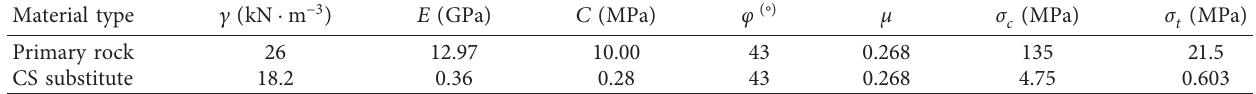
Table 1: Physicomechanical parameters of prototype rock and cemented sand substitute.